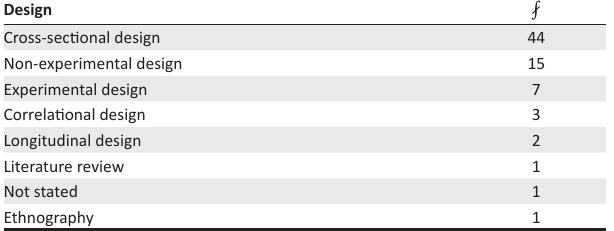
TABLE 3: Design use in sample frequency.